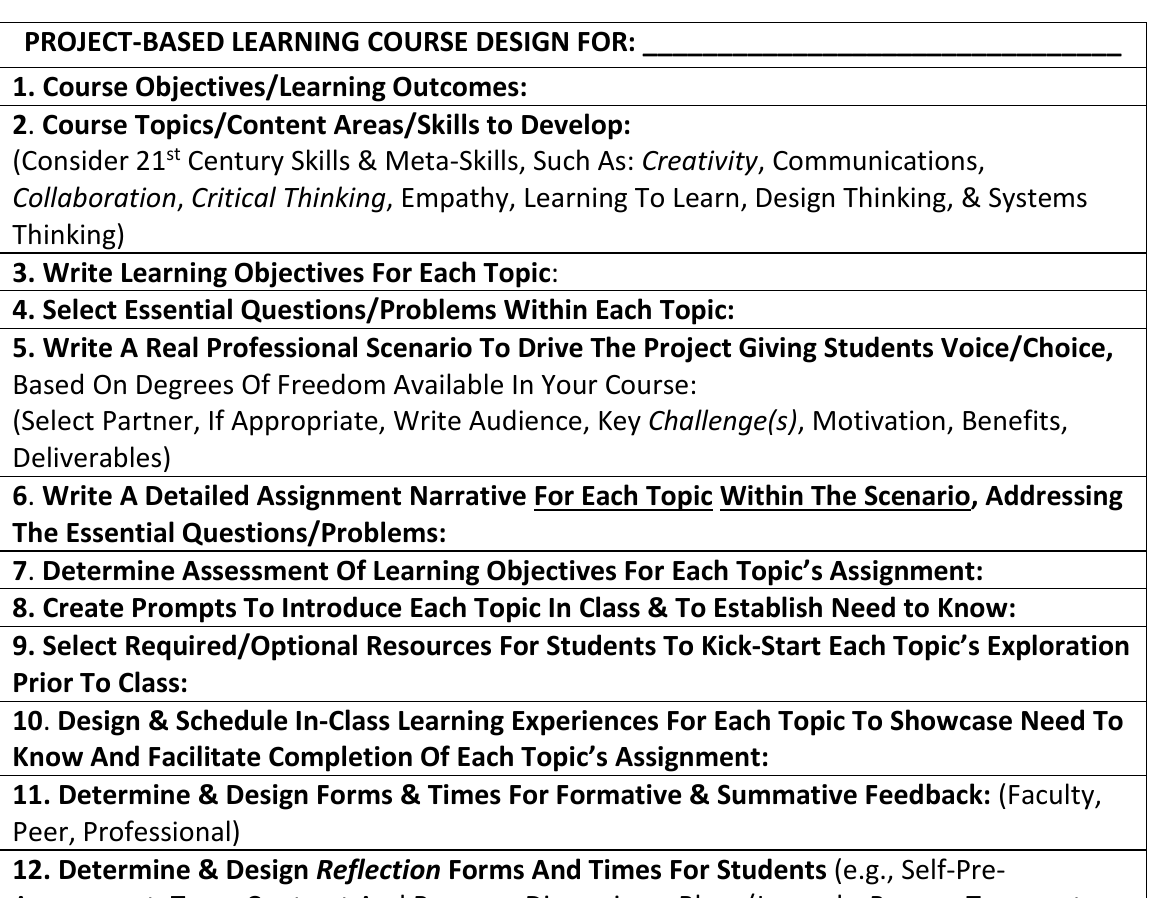
Table 1. Project-Based Learning Course Design